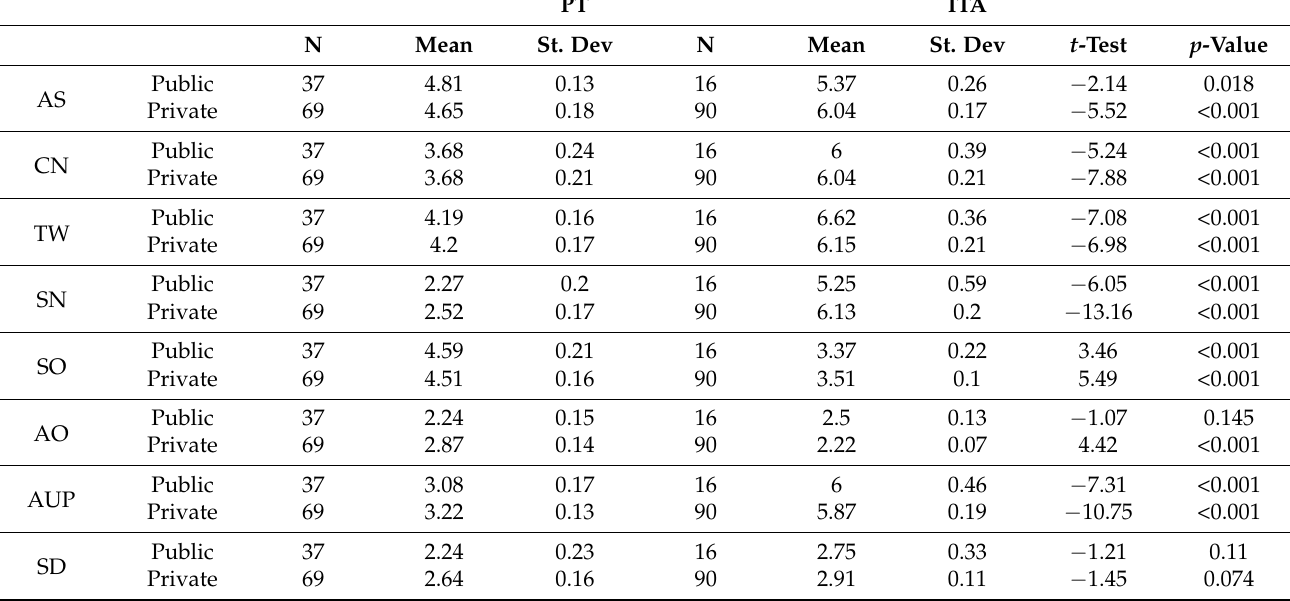
Table 4. Self-assessment of competences according to the